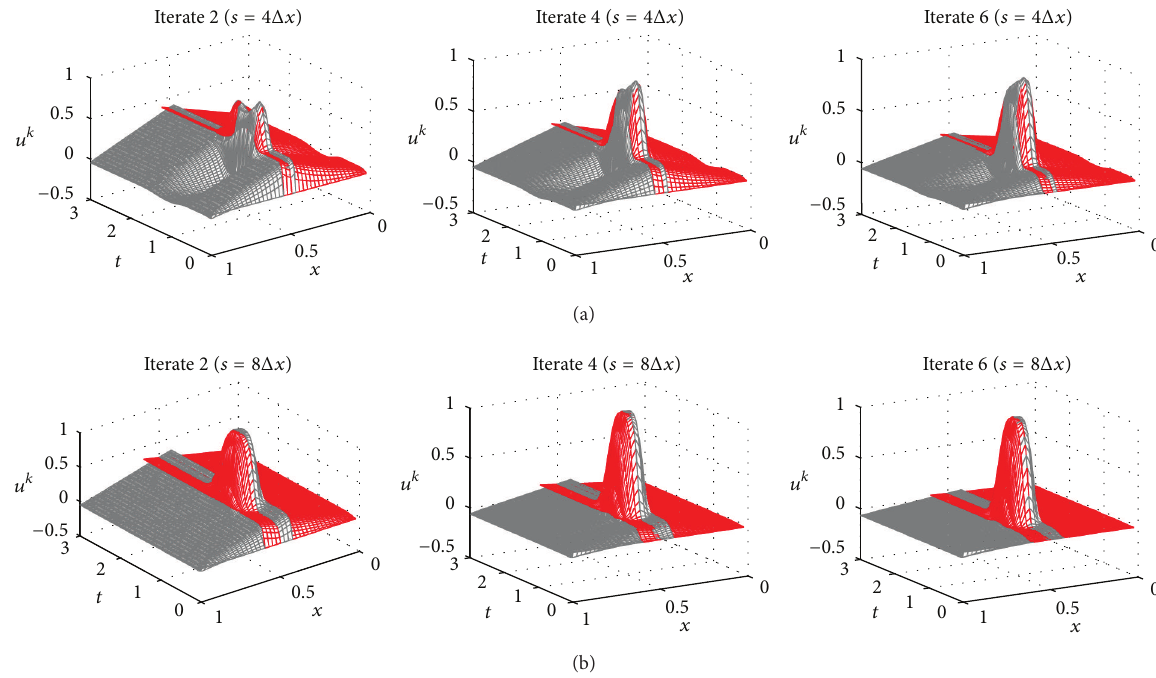
Figure 1: Influence of the overlap size on the convergence rate of the SWR algorithm. Top: with 𝑠 = 4Δ𝑥 the solution generated by the SWR algorithm after 2, 4, and 6 iterations; bottom: the similar information for 𝑠 = 8Δ𝑥 .